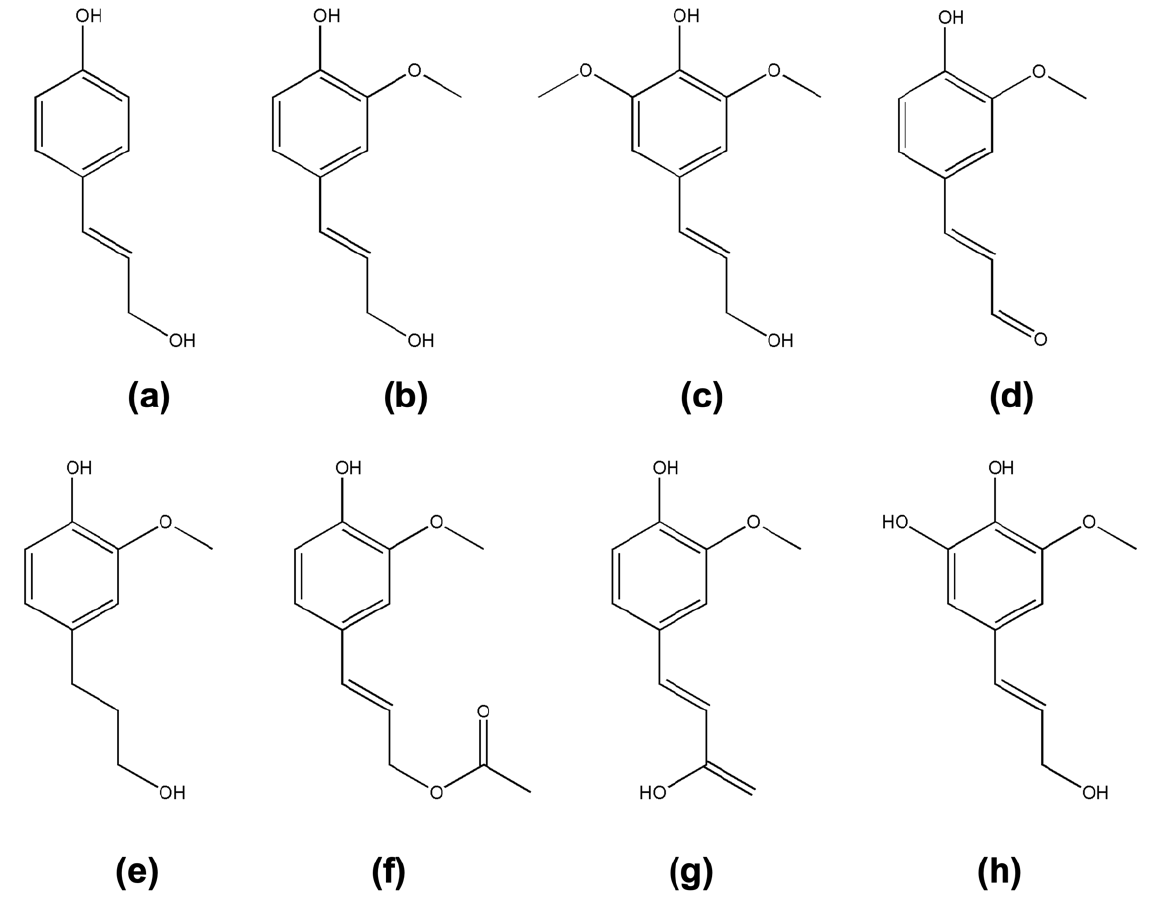
Figure 2. Monolignols typically found in lignin: p-coumaryl alcohol ( a ), coniferyl alcohol ( b ), sinapyl alcohol ( c ), coniferaldehyde ( d ), dihydroconiferyl alcohol ( e ), coniferyl alcohol-9-acetate ( f ), ferulic acid ( g ), and 5-hydroxyconiferyl alcohol ( h ).